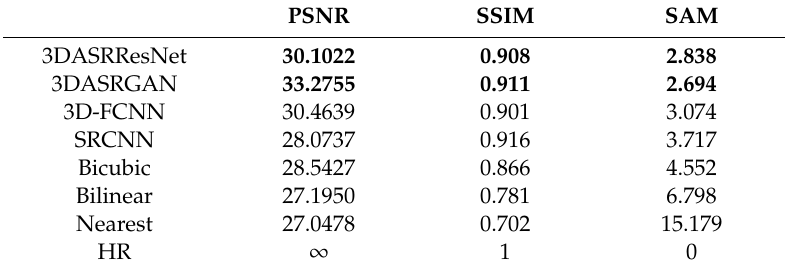
Table 2. Quantitative comparison results of di ff erent SR methods based on the Urban dataset. PSNR SSIM